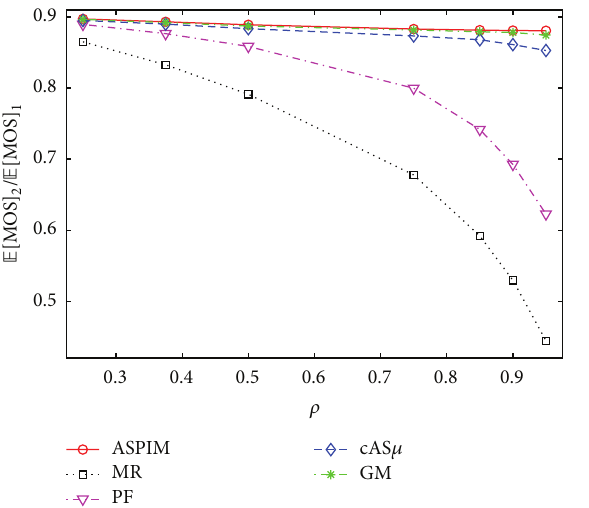
Figure 7: E [MOS] for abrupt MOS scenario. Figure 8: E [MOS] under higher error due to rate.